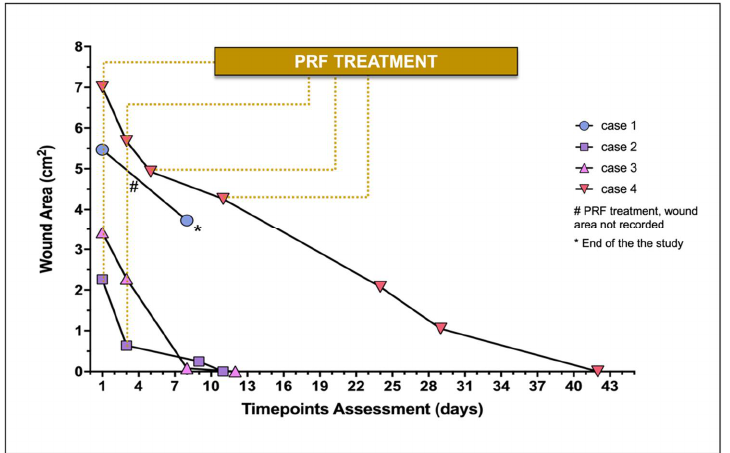
Figure 2. Wound area of treated wounds ( n = 4) during the study. Individual wound evaluation and treatment (constituted by the PRF-grafting procedure) are represented. The initial surface area of the major skin wounds recorded 5.47 cm 2 (case 1) and 7.01 cm 2 (case 4), receiving 2 and 4 PRFs, respectively, providing complete wound covering.